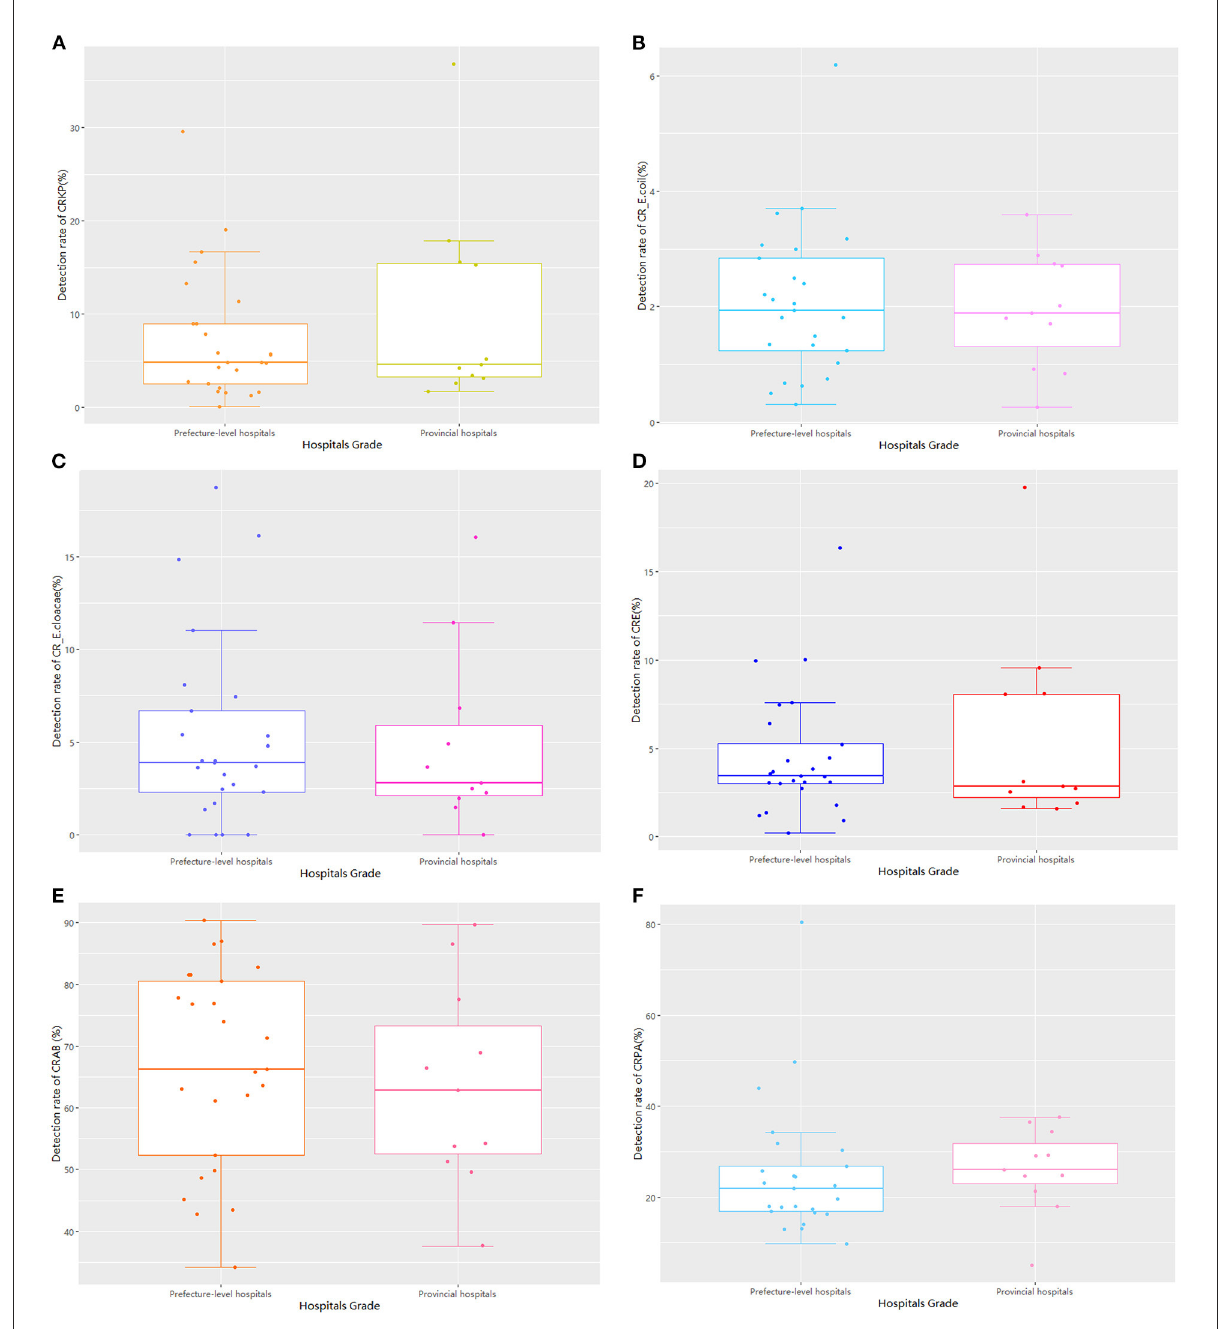
FIGURE4 The comparison of detection rates of GNRB based on hospital administrative levels.